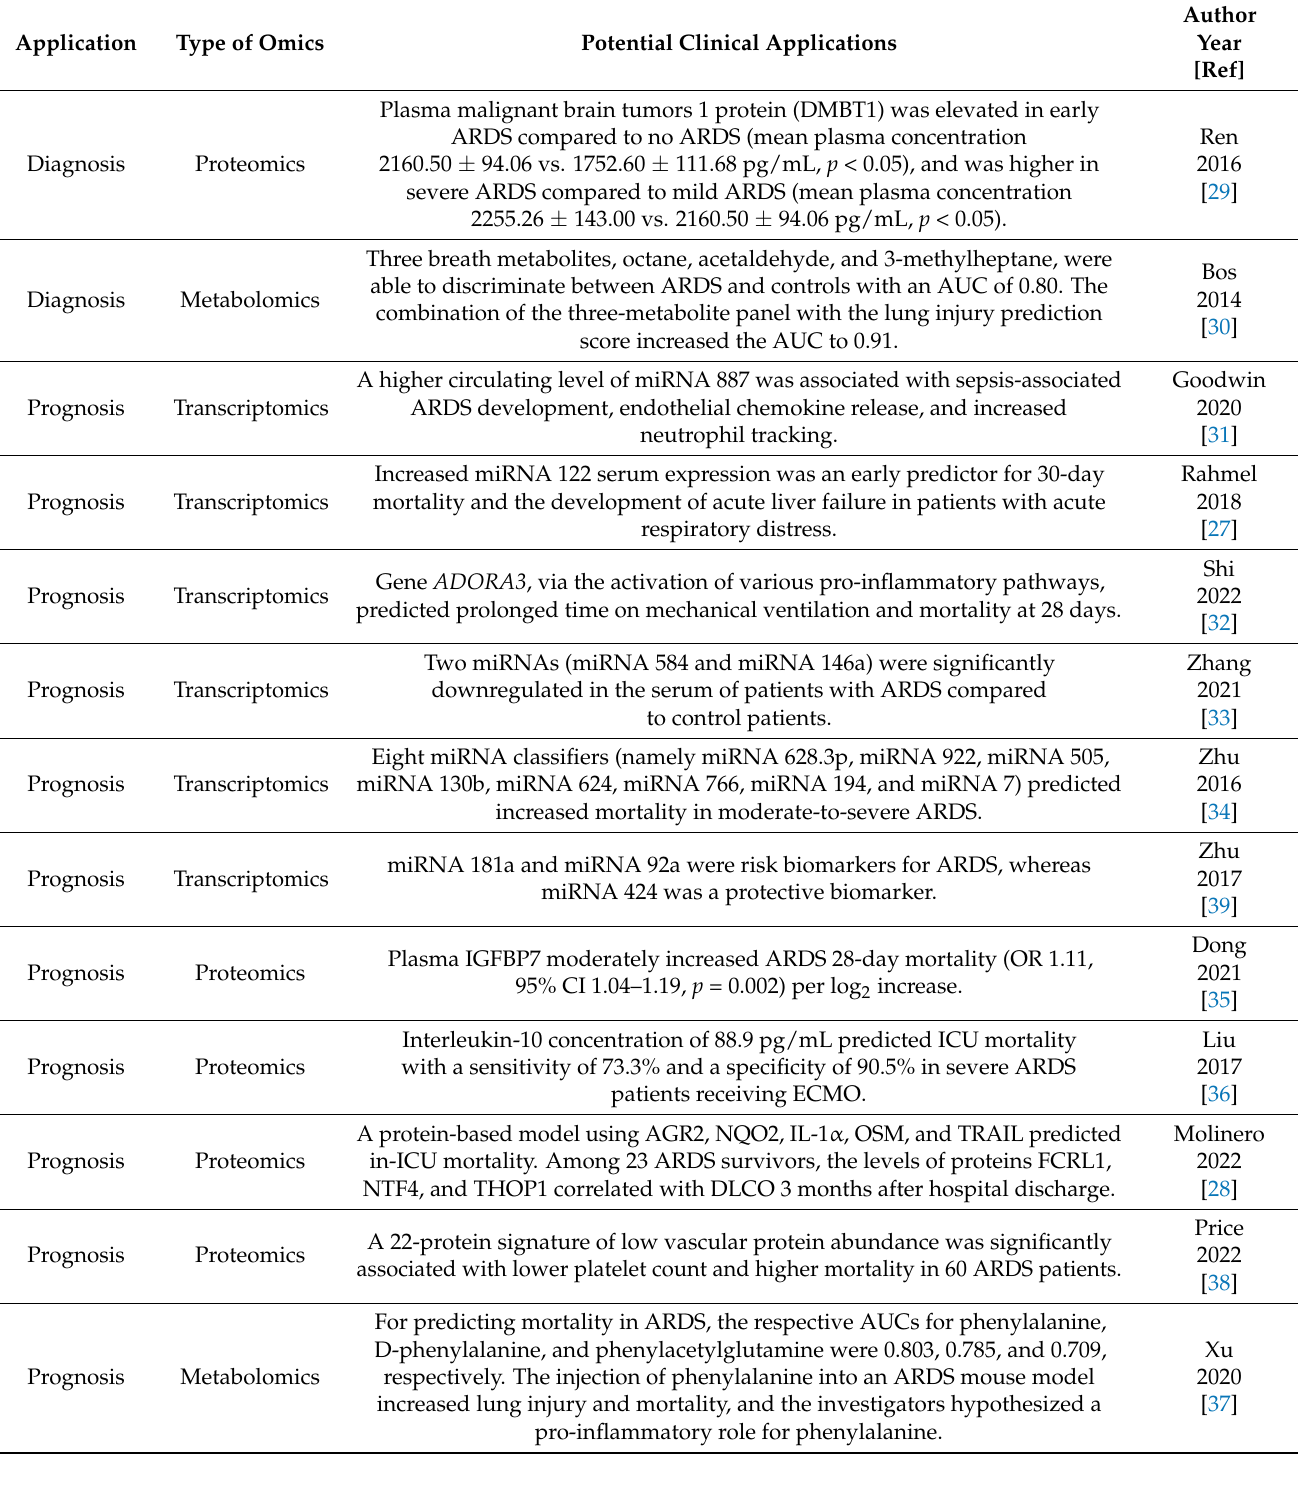
Table 2. Omics for acute respiratory distress